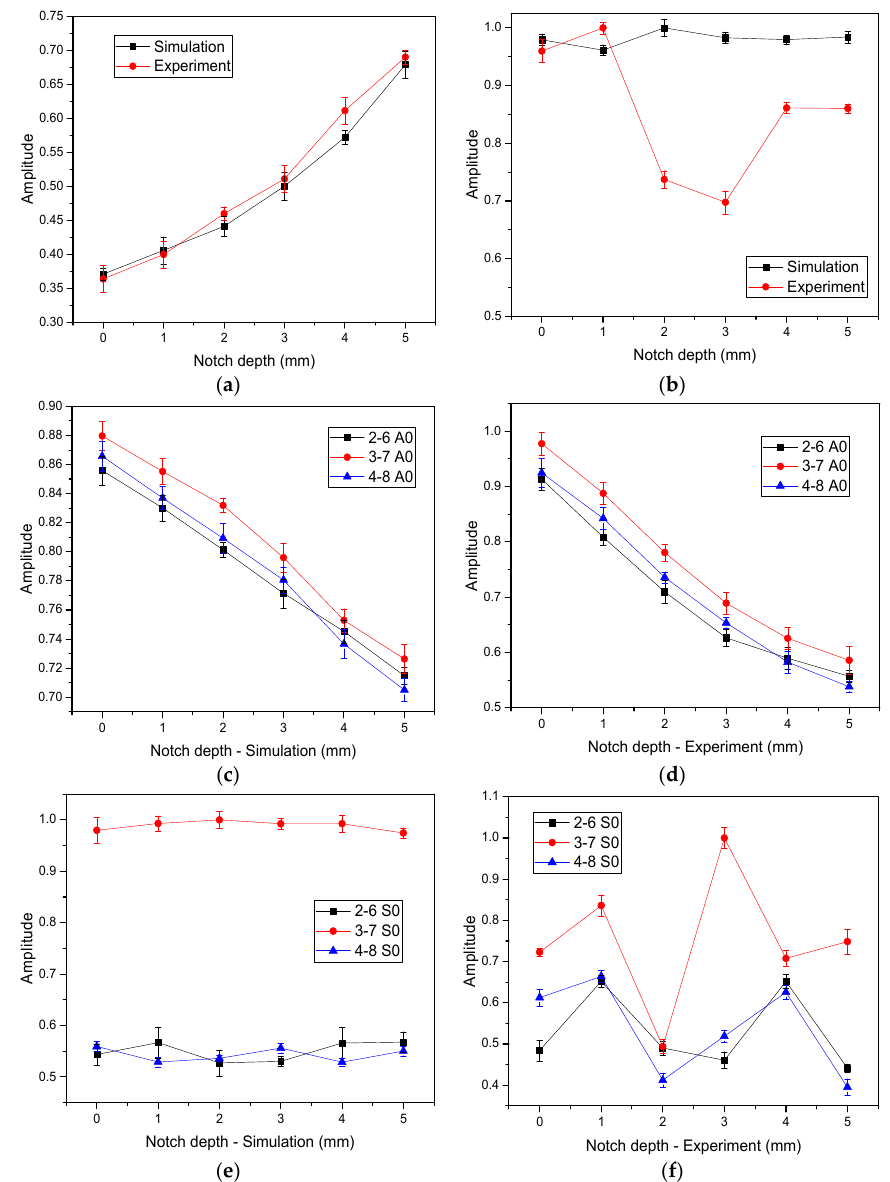
Figure 9. Amplitude of A0 and S0 signals varies with the notch depth. ( a ) S0 mode in the